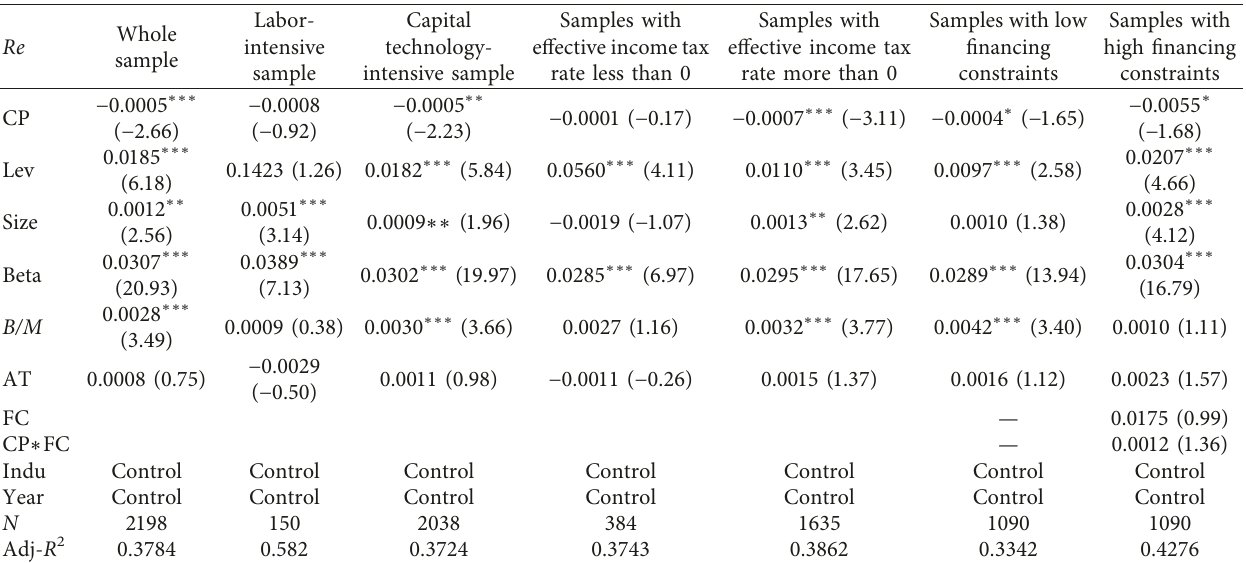
Table 5: Multivariate regression test (whole sample and grouping sample).